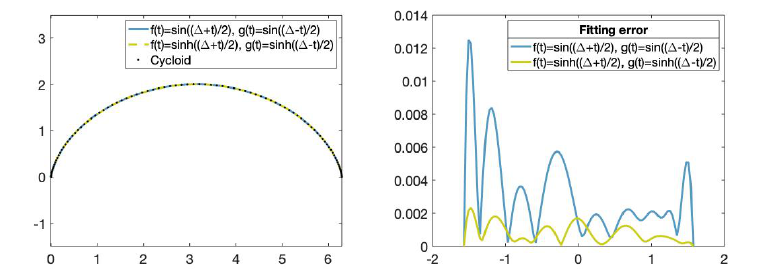
Figure 11. ( Left ): Set of data points on the cycloid (dotted), fitting curve obtained using the trigonometric functions f ( t ) = sin (( ∆ + t ) /2 ) and g ( t ) = sin (( ∆ − t ) /2 ) and fitting curve obtained using the hyperbolic functions f ( t ) = sinh (( ∆ + t ) /2 ) and g ( t ) = sinh (( ∆ − t ) /2 ) . ( Right ): Fitting error comparison. The x -axis represents the parameters t in [ − ∆ , ∆ ] and the y -axis represents the curvature error value of the fitting curve obtained using the trigonometric and hyperbolic